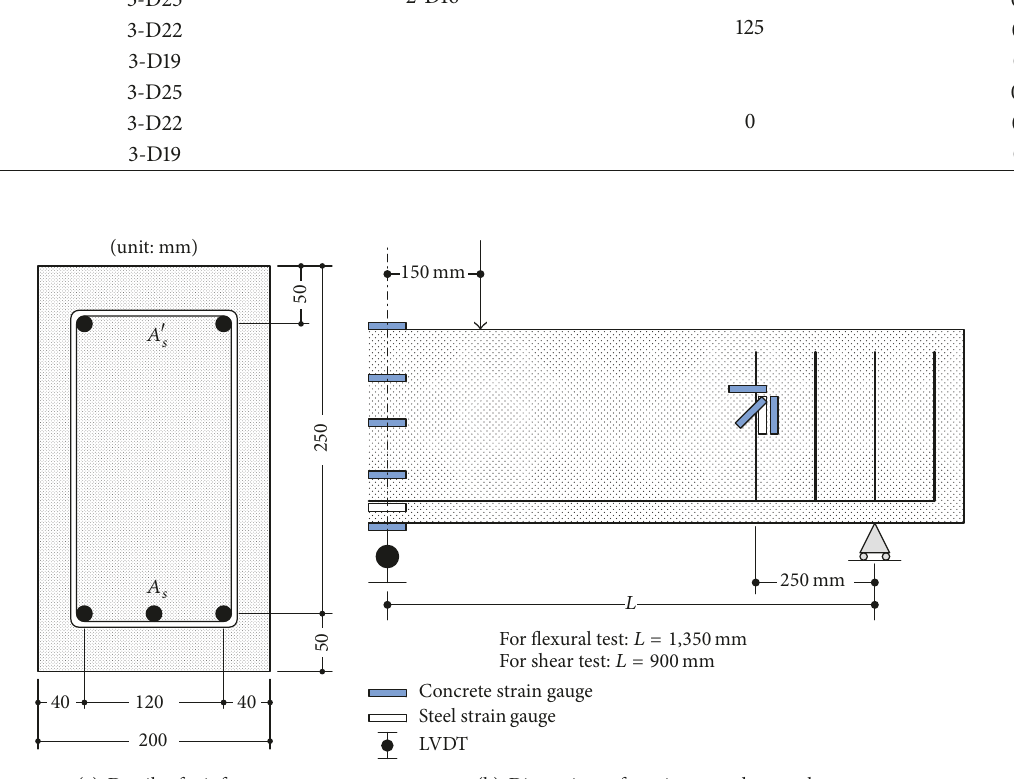
Figure 2: Cross-sectional details and sensor layout of AAS concrete beam specimens.